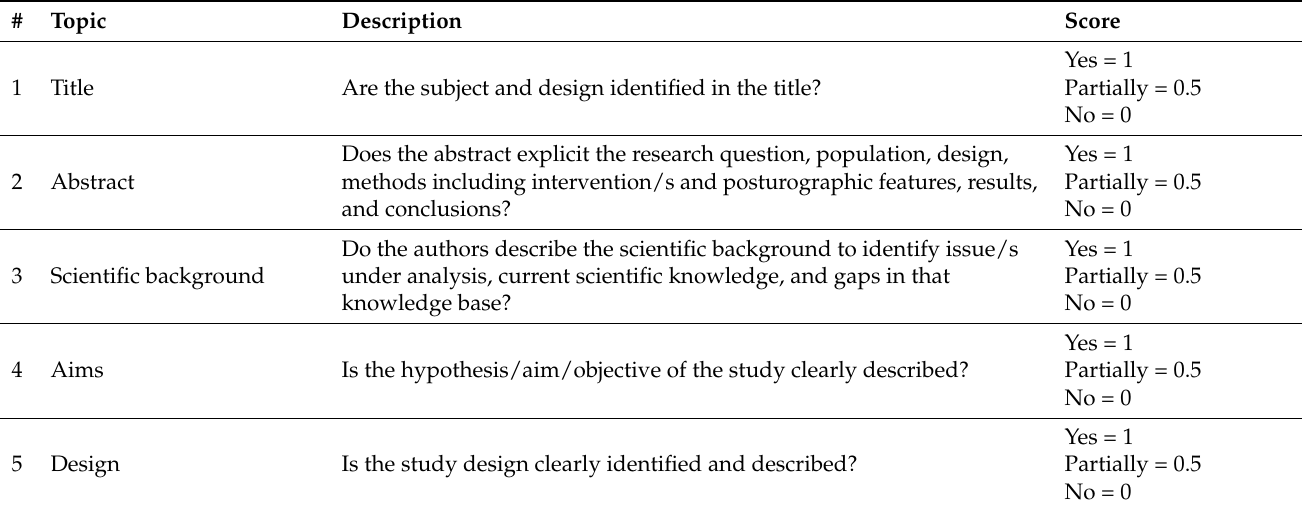
Table A1. Individual risk of bias